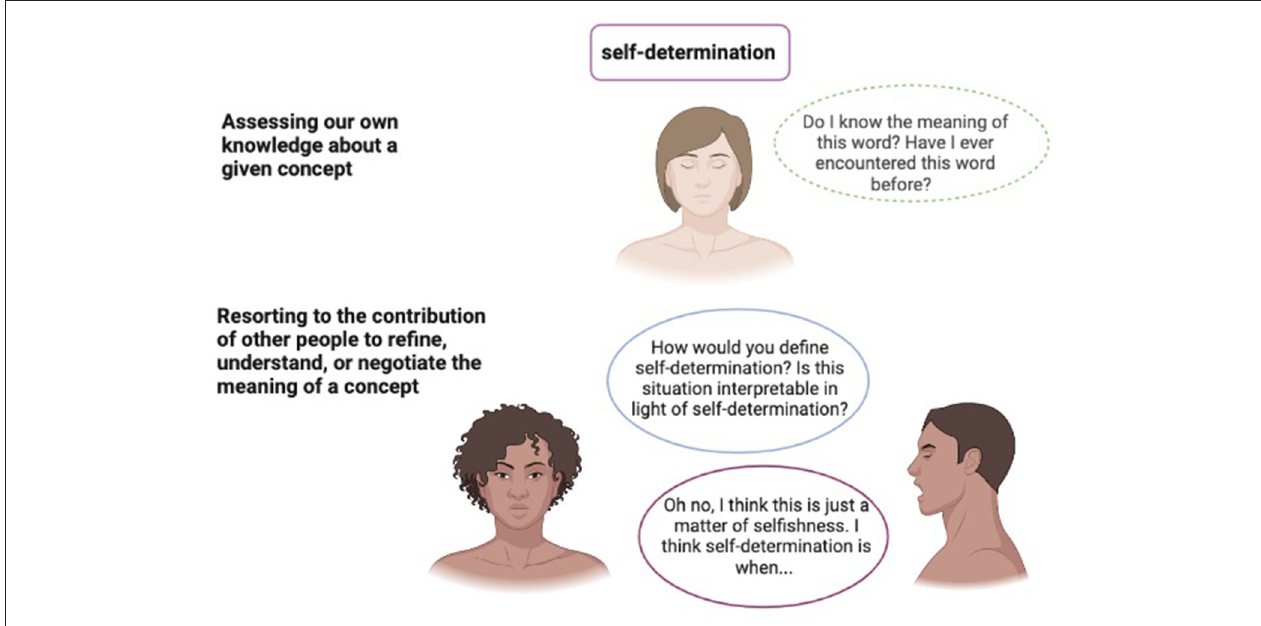
FIGURE 1 | The process of social